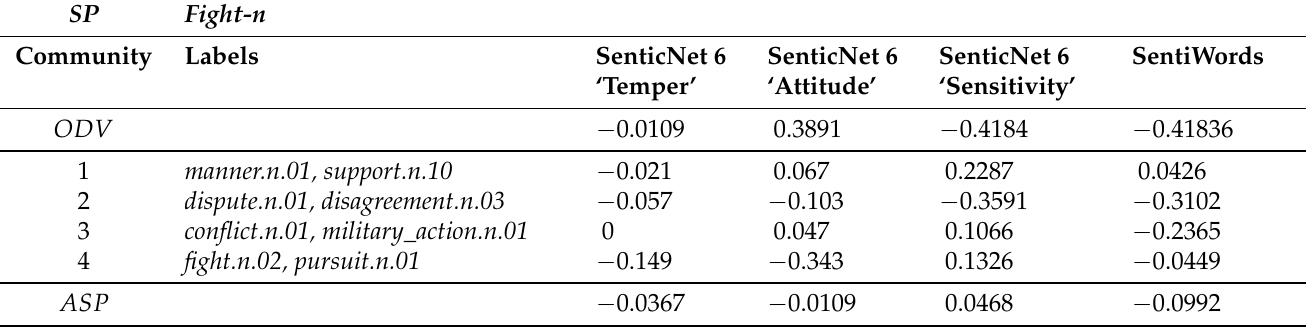
Table 9. Sentiment potential ( SP ): Propagated SenticNet 6 dimensions: temper, attitude, sensitivity, and SentiWords GSV of lexical communities for seed lexeme fight-n calculated on ententen13